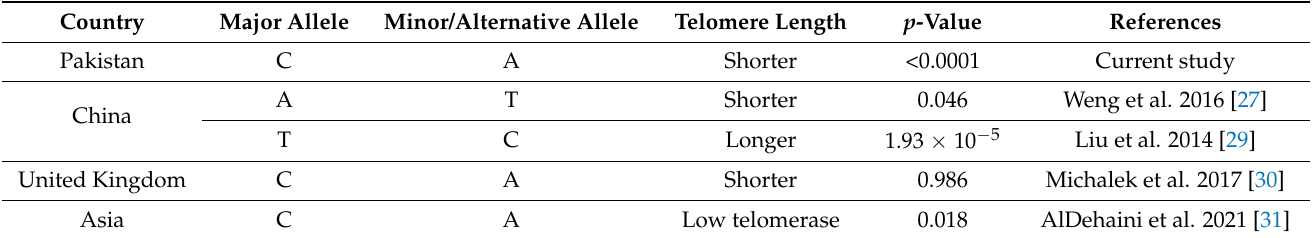
Table 5. Major and minor alleles effect on Telomere Length in different